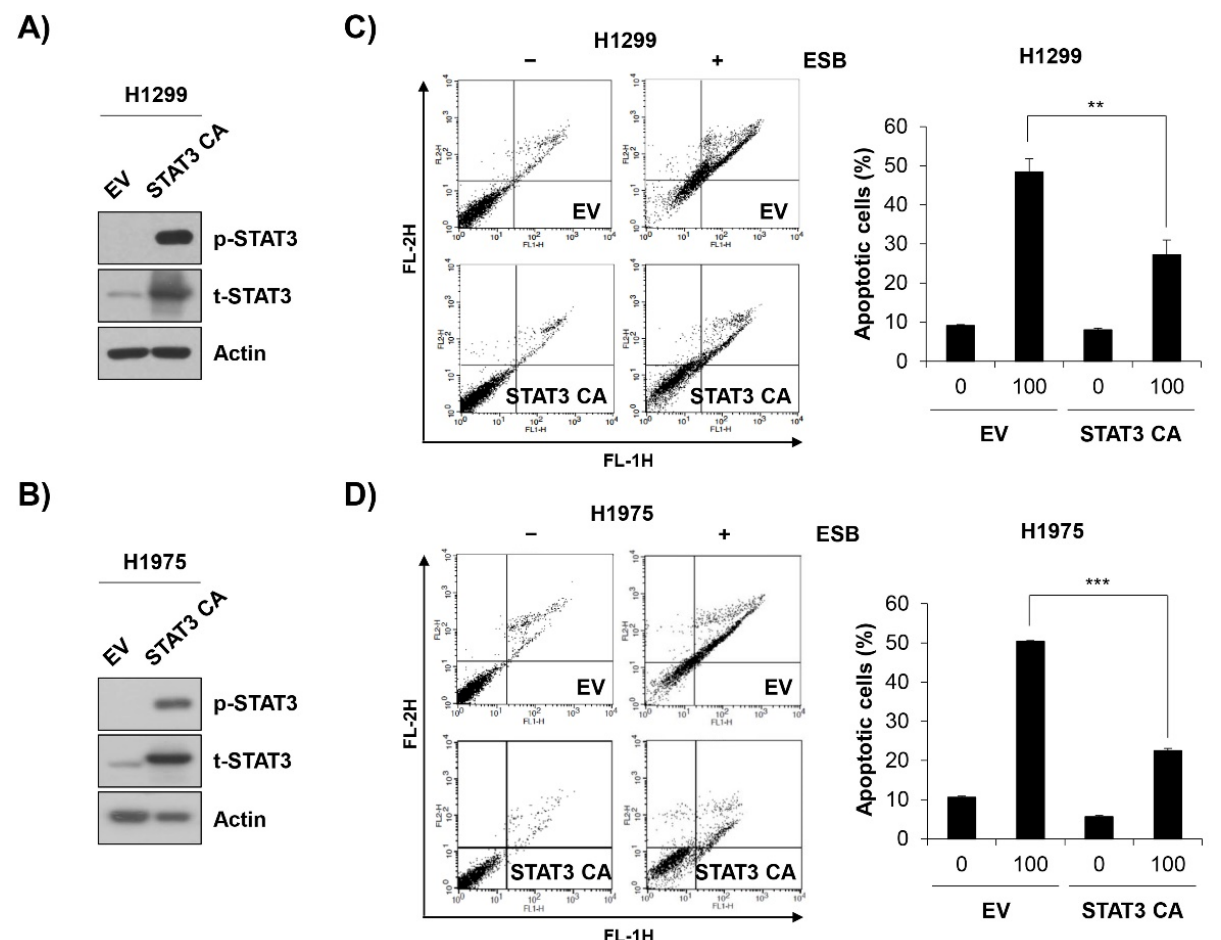
Figure 7. ESB-induced apoptosis in EGFR TKI-resistant human NSCLC cell lines was mediated by STAT3 activity suppres- sion. H1299 cells and H1975 cells were transfected with constitutively active STAT3 (STAT3 CA) plasmid or empty vector. ( A , B ) At 48 h post-transfection, the levels of phosphorylated and total STAT3 in H1299 cells ( A ) and in H1975 ( B ) were detected by Western blot analysis. ( C , D ) At 48 h post-transfection, H1299 cells ( C ) and H1975 ( D ) were seeded again for annexin V-PI double staining assay and treated with ESB (100 µ g/mL) for 72 h. The annexin V- and/or PI-stained cells were analyzed by flow cytometry. Representative plot images are shown (left panel). The percentage of annexin V-positive cells was measured by CellQuest software (right panel). The data are expressed as the mean ± SD of three independent experiments. Significance was determined by the Student’s t -test (** p < 0.01, *** p < 0.001 vs. untreated controls). ESB, ethanol extract of the root of Scutellaria baicalensis; NSCLC, non-small-cell lung cancer; EGFR TKI, Epidermal growth factor receptor tyrosine kinase inhibitor; STAT3, signal transducer and activator of transcription 3; SD, standard deviation.